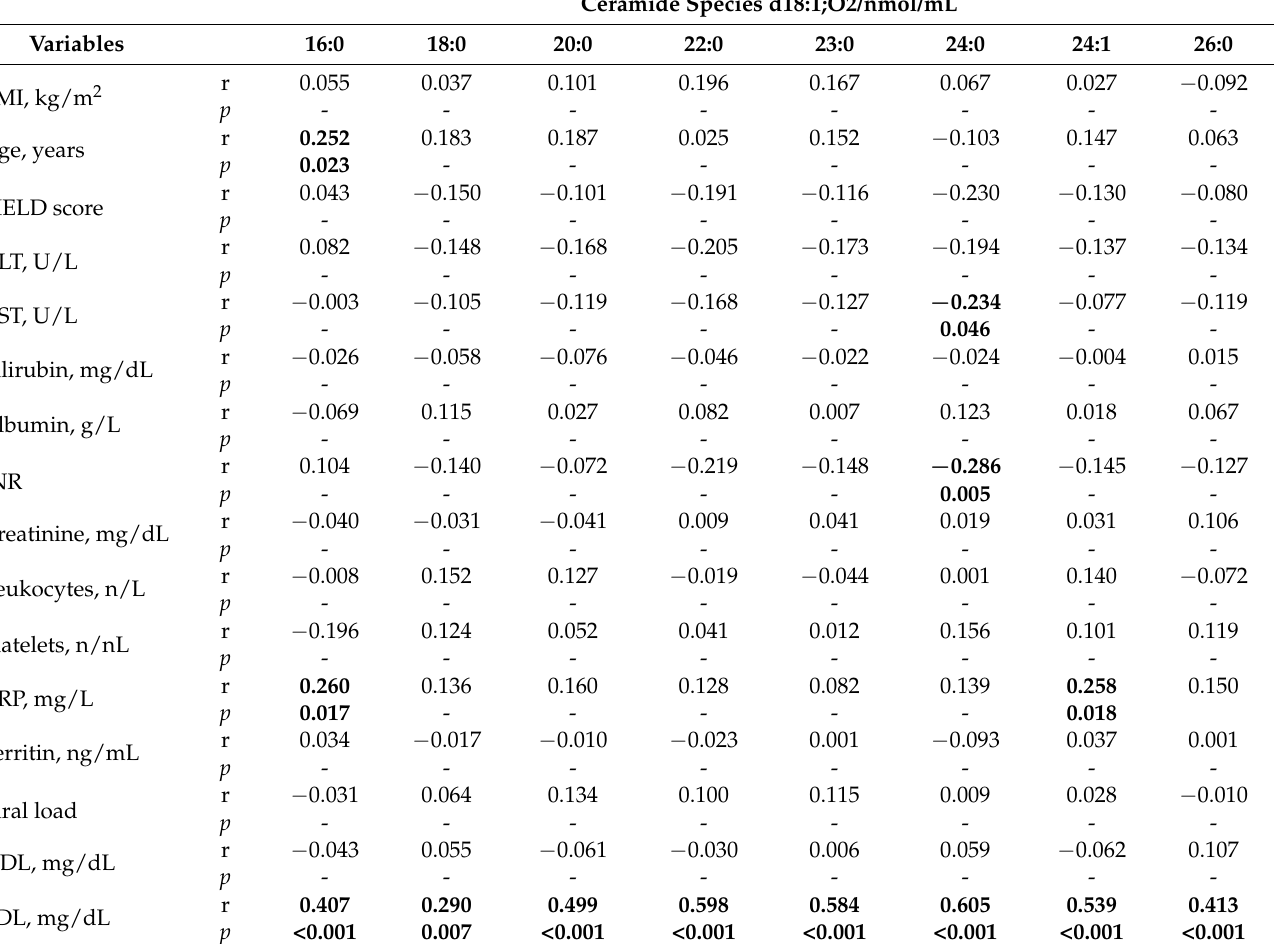
Table 3. Spearman correlation coefficients and p -values for the correlations of ceramide species with BMI, age, MELD score, viral load, and routine laboratory parameters in the 138 HCV patients without liver cirrhosis before direct-acting antiviral (DAA) therapy. Significant correlations are in bold (alanine amino transferase (ALT), aspartate aminotransferase (AST), body mass index (BMI), C-reactive protein (CRP), high-density lipoprotein (HDL), international normalized ratio (INR), low-density lipoprotein (LDL), model of end-stage liver disease (MELD), not significant (ns)).